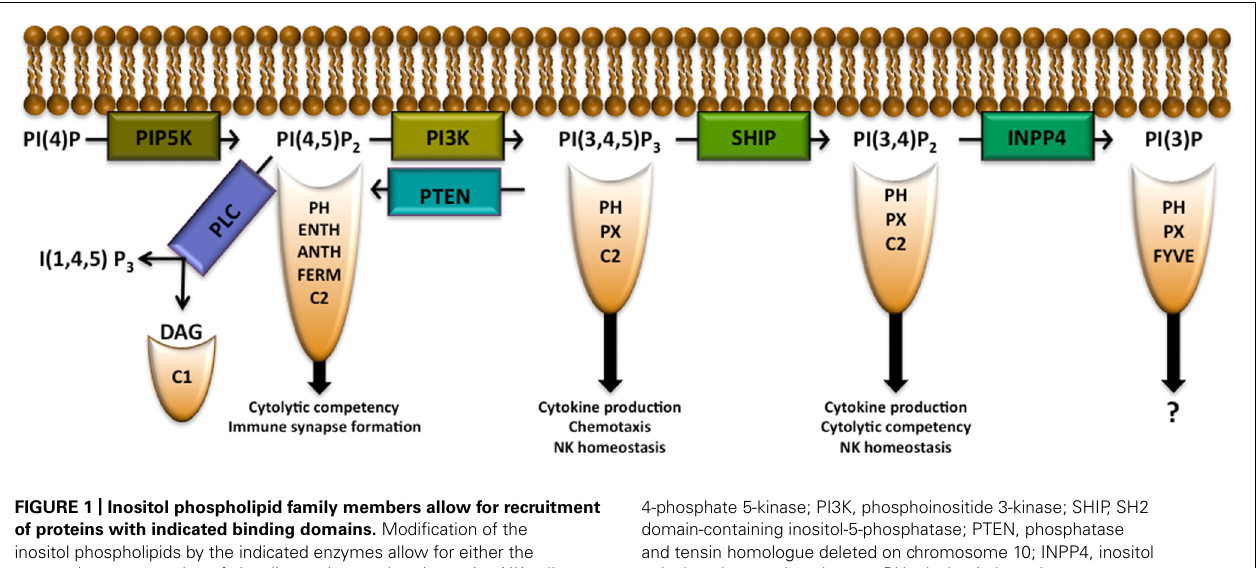
and tensin homologue deleted on chromosome 10; INPP4, inositol polyphosphate 4-phosphatase; PH, pleckstrin homology;